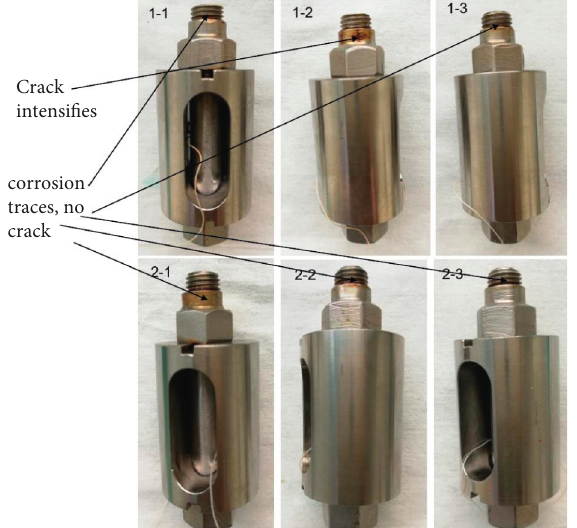
Figure 15: The surface condition of the test piece soaked in boiling magnesium chloride solution for